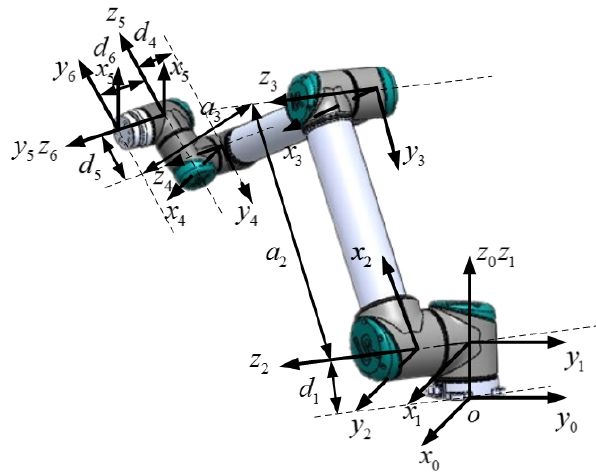
Figure 1. Joint coordinate system of jean-fabric-grinding robot.